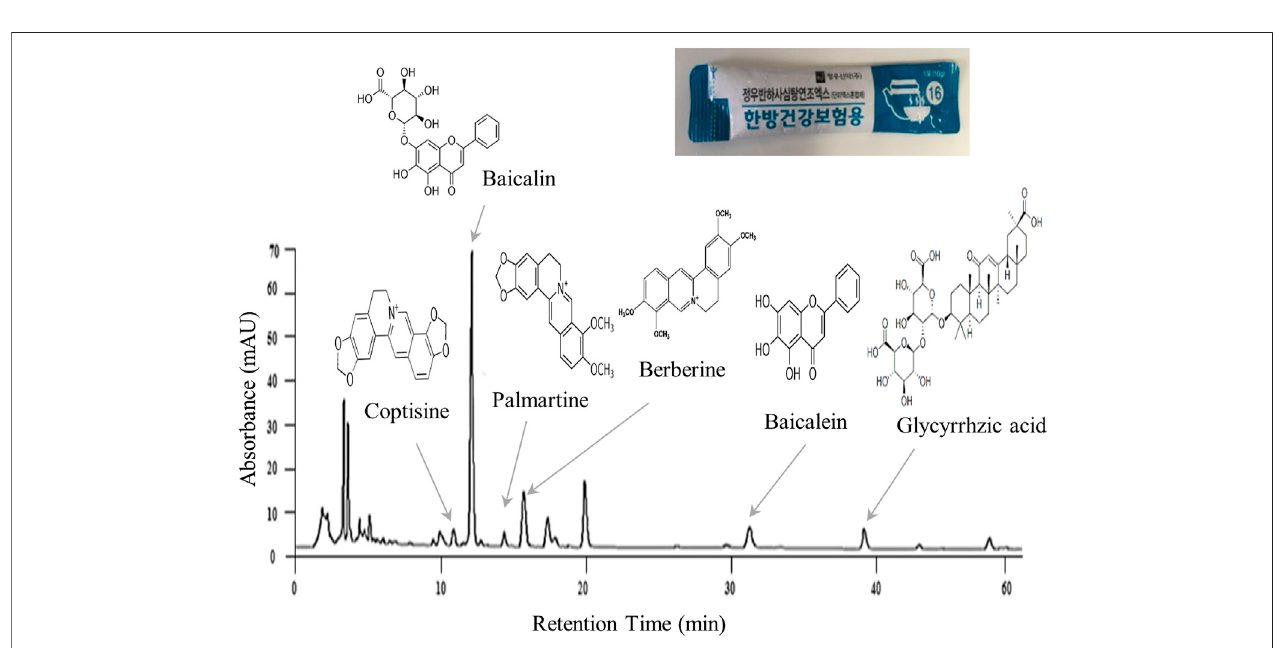
FIGURE 2 | Molecular fi ngerprinting of Banha-Sasim-Tang